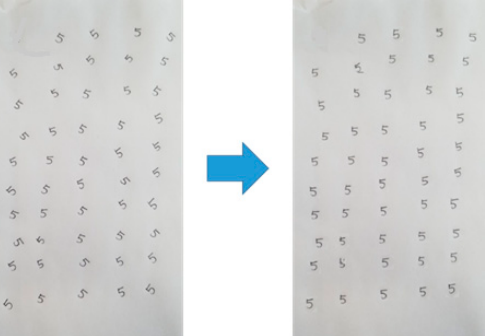
Figure 18. Tilt correction examples of “5” following the proposal ( left : original, right : tilt correction results).